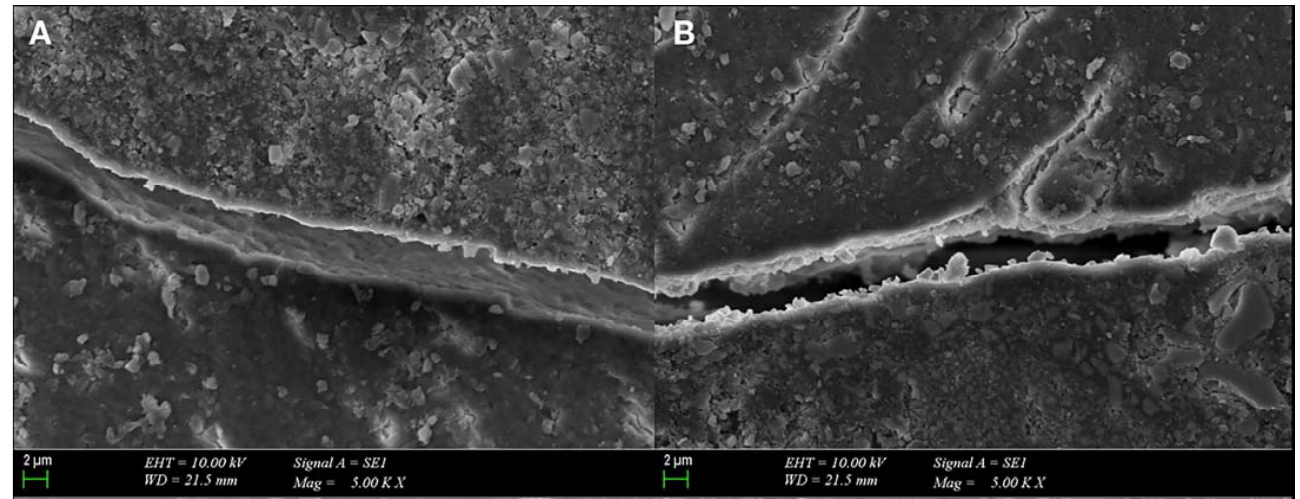
Figure 5. ( A , B ) Gap formation in the adhesive is observed in the SEM micrographs (X5000) of the samples from G2 (XF4 mm + XB2 mm) and G3 (TNB2 mm + TFB4 mm).